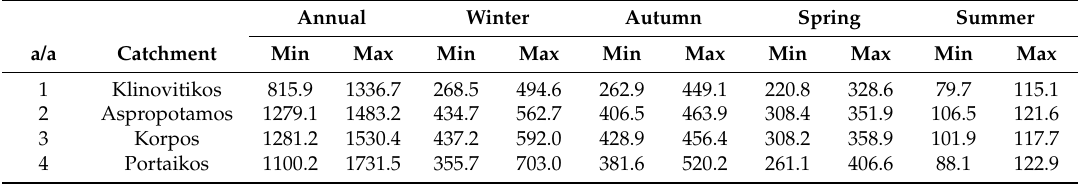
Table 10. Annual and seasonal rainfall (mm) ranges in the catchments of the study area.